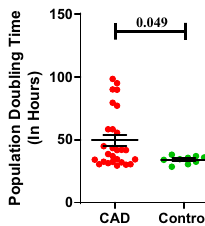
Figure 3. Population doubling time of ECFCs in CAD and healthy control subjects. Mean cell proliferation in terms of population doubling time (PDT) of ECFCs from CAD patients (n = 27) and control subjects (n = 09). In the histogram, Y axis represent PDT in hours and X axis represent the study groups (CAD and control group). Student t-test was used to assess the significance difference. Data is represented as mean ± SE. Error bar represent standard error of mean; dots represent average values of the parameters obtained from experimental duplicates; p ≤ 0.05 considered statistically significant.